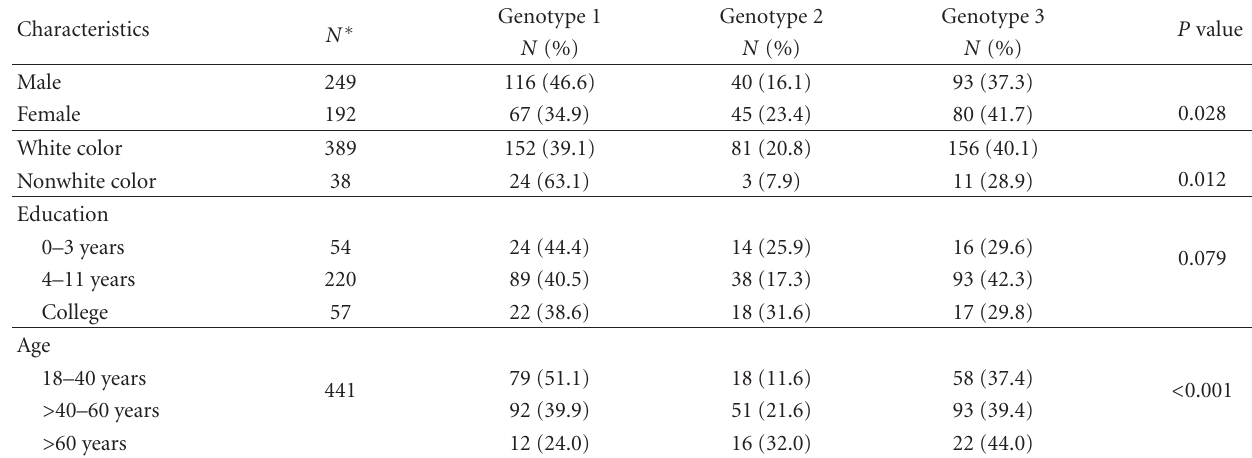
Table 1: Sociodemographic characteristics of hepatitis C virus infected patients according to genotype.